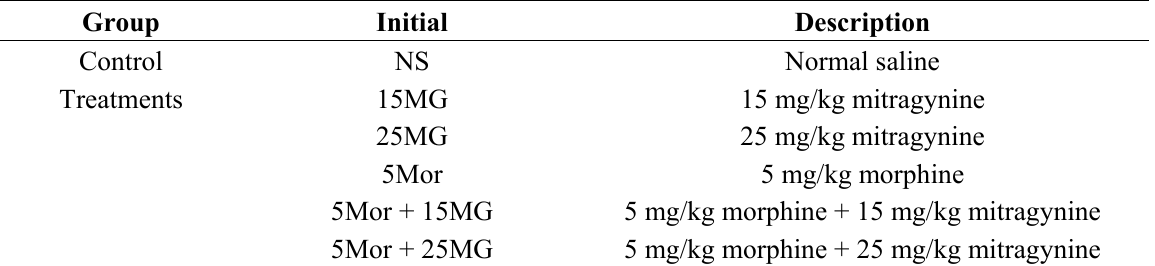
Table 1. Illustration of each group and its respective